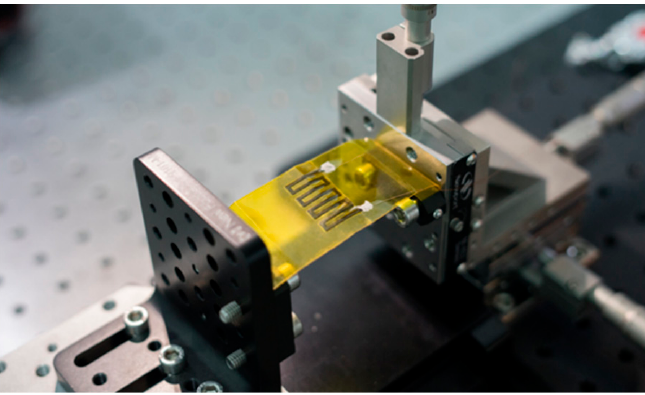
Figure 7. Optical image of the experimental setup for bending strain test.